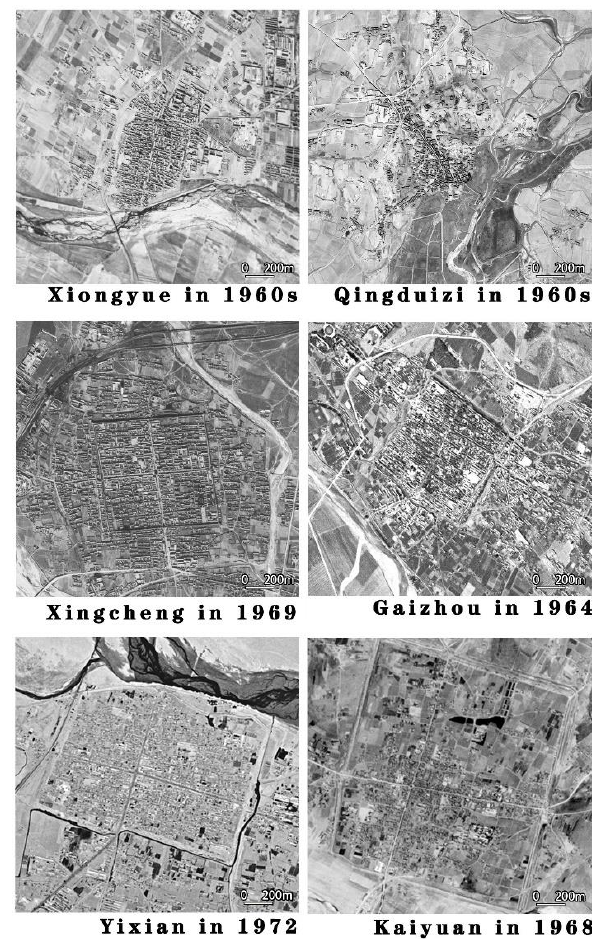
Figure 2. Ancient cities in Liaoning Province in the 1960s– 1970s. Source: Ancient satellite photos from